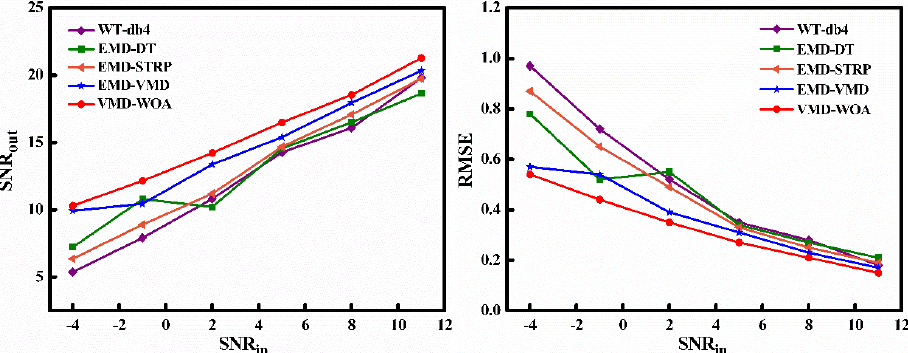
Figure 7. Denoising performance with different SNR in on the noisy Bumps signal.